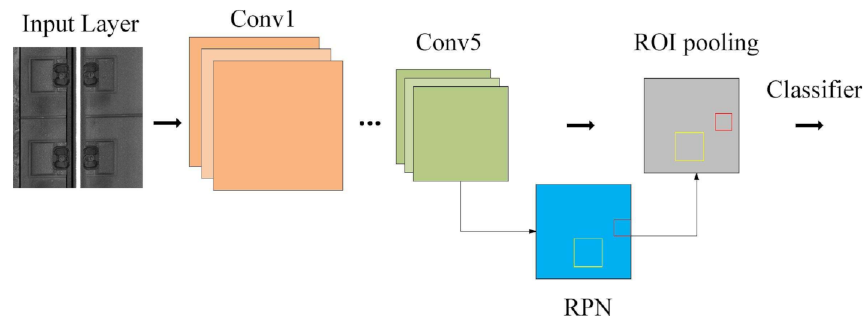
Figure 2. Illustration of the Faster R-CNN’s internal architecture